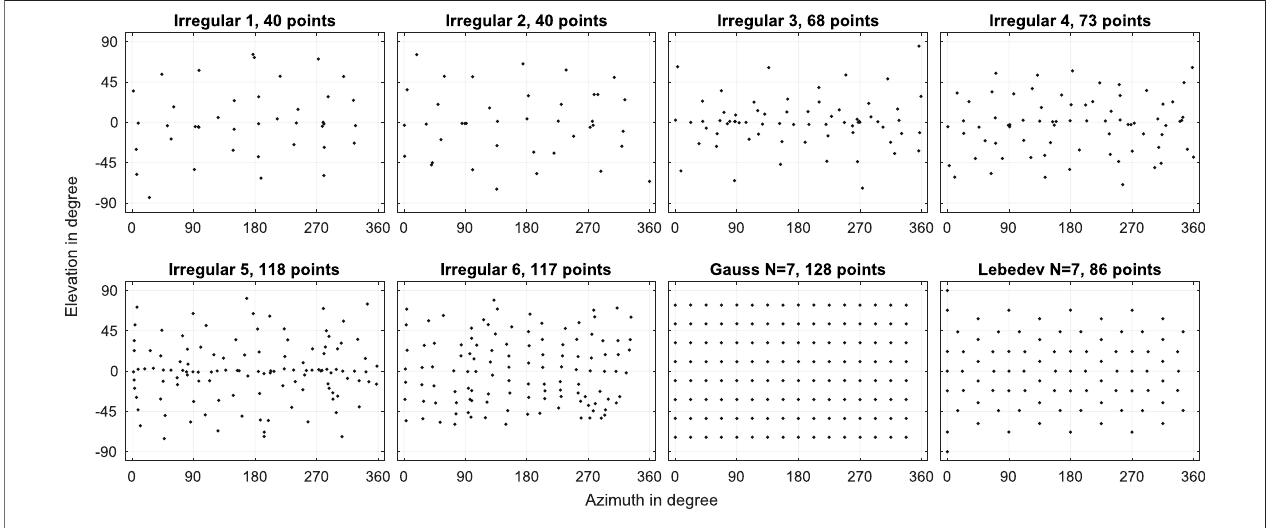
FIGURE 1 | Examined six irregular test sampling grids and two regular grids for